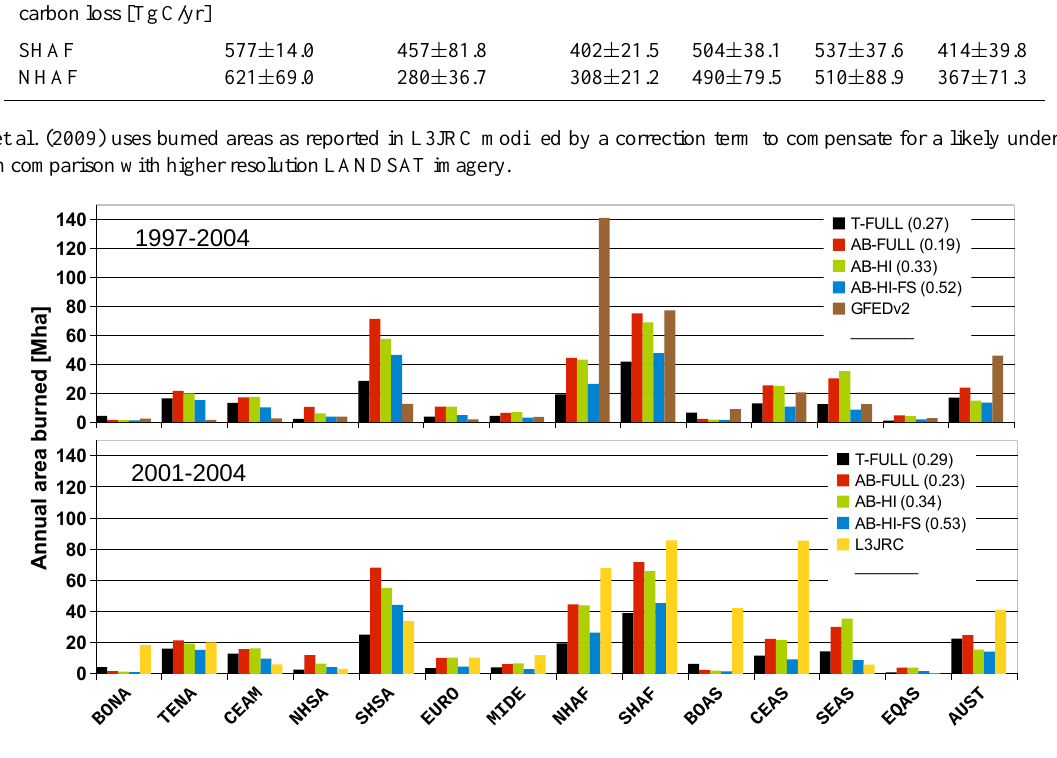
Fig. 2. Annual mean total area burned (wildfire plus deforestation) in [Mha] for different regions compared to GFEDv2 (van der Werf et al., 2006) and L3JRC (Tansey et al., 2008). The model simulations were averaged over the corresponding observational period (1997–2004, 2001– 2004, respectively). The number in brackets denote spatial correlation coefficients between simulations and satellite-based fire products. Regions are defined in Fig.